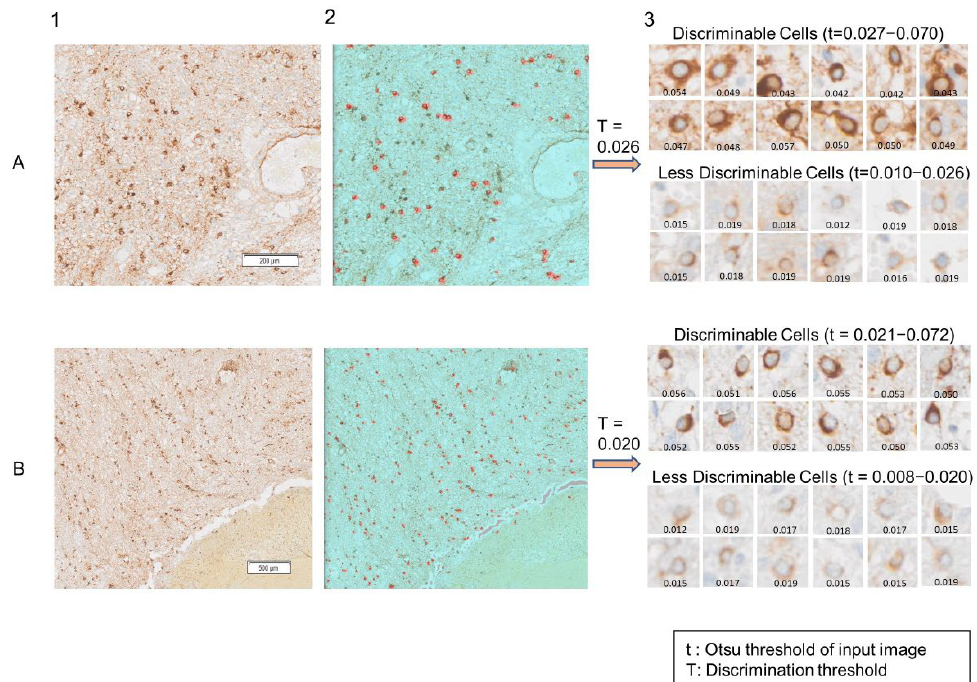
Figure 5. ( A , B ) The prediction results generated by the BCNN model for two independent cases. ( 1 ) Low-magnification view of an area showing “halo cells”; ( 2 ) the corresponding predicted heatmap revealing the detected “halo cells” (in red). ( 3 ) Visualizations of the results of the filtering and thresholding process: ( 3A , 3B ) upper panel: discriminable cells that returned Otsu values exceeding the discrimination threshold, ( 3A , 3B ) lower panel: Less discriminable cells whose Otsu value fell below the discrimination threshold. Scale bar: microns.